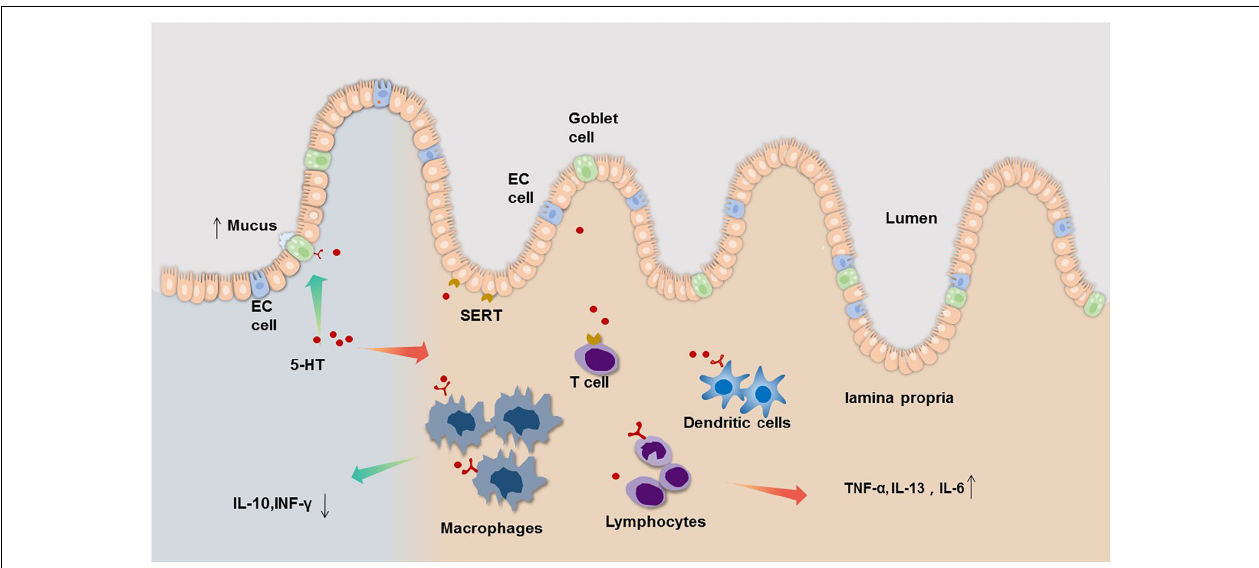
FIGURE 1 | The bidirectional neuroimmune interactions of 5-HT in the regulation and consequences of intestinal inflammation. Evidence from clinical and animal studies indicate that EC cells of the gastrointestinal (GI) tract are the main source of mucosal 5-HT, which acts a pro-inflammatory mediator by regulating immune cell activation leading to increased pro-inflammatory cytokine, such as TNF- α , IL-13, IL-6 (right side) . However, 5-HT also can act on 5-HT receptors on goblet cells to increase mucus secretion, and decrease IL-10, INF- γ through regulating 5-HT receptors on immune cell (left side)